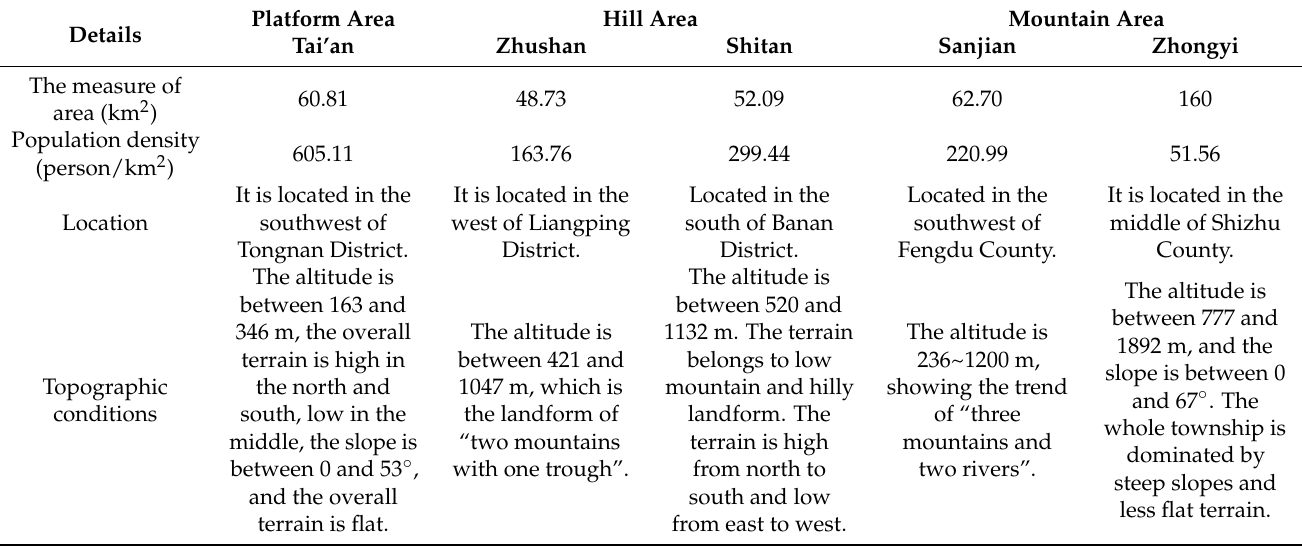
Table 1. Basic characteristics of the study